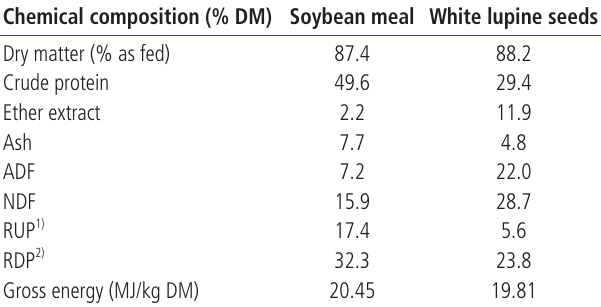
DM, dry matter; ADF, acid detergent fiber; NDF, neutral detergent fiber; RUP, rumen undegradable protein; RDP, rumen degradable protein. 1) RUP, calculated according to INRA [22]. 2) RDP, calculated according to INRA